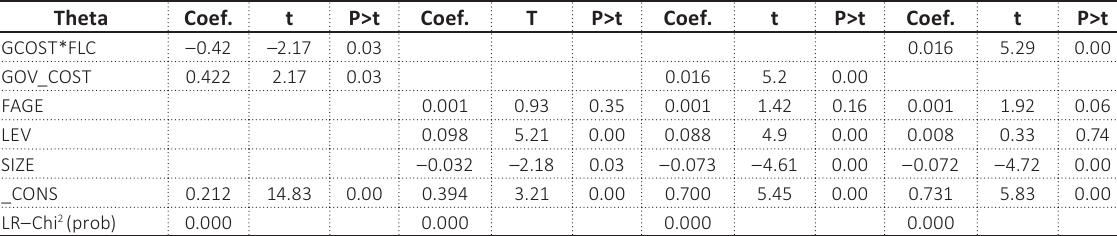
Table 7, Regression Analysis of Governance Cost